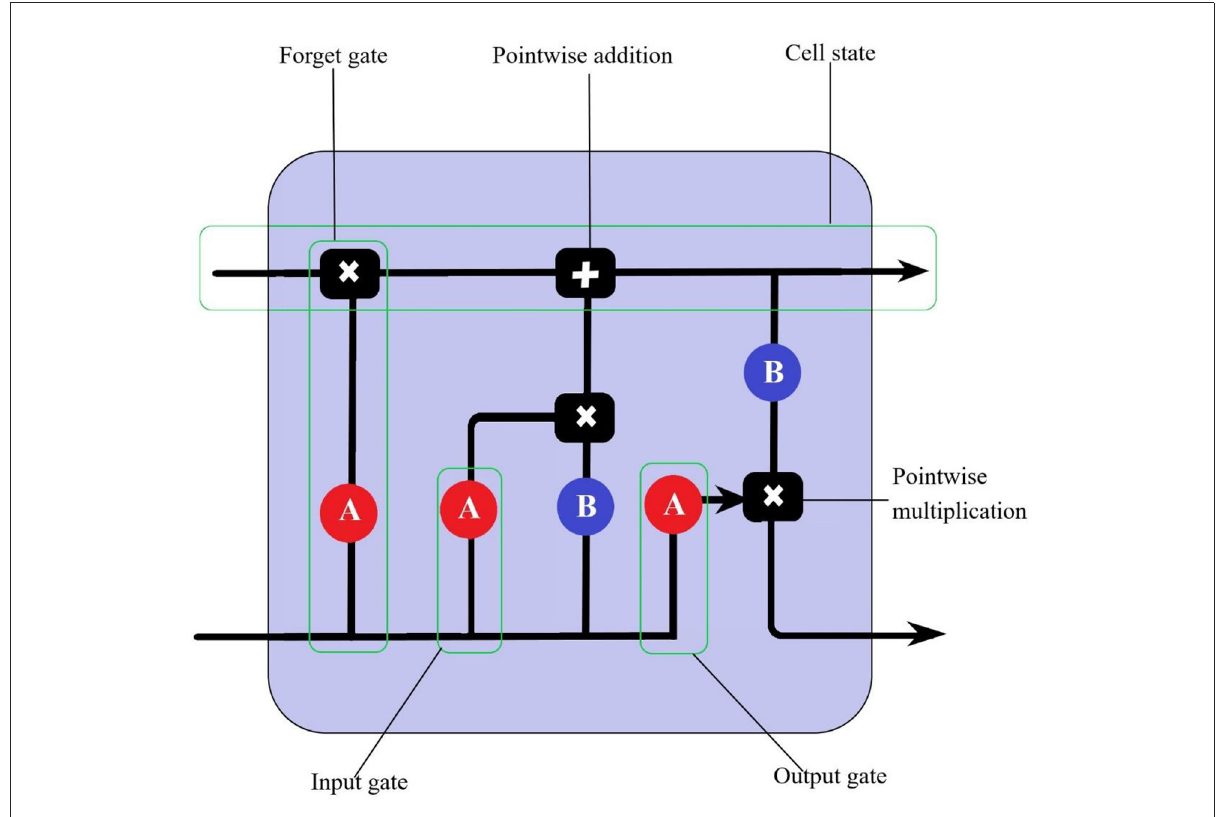
FIGURE2 The LSTM cell consists of an input gate, an output gate and an oblivion gate. A and B are activation functions.